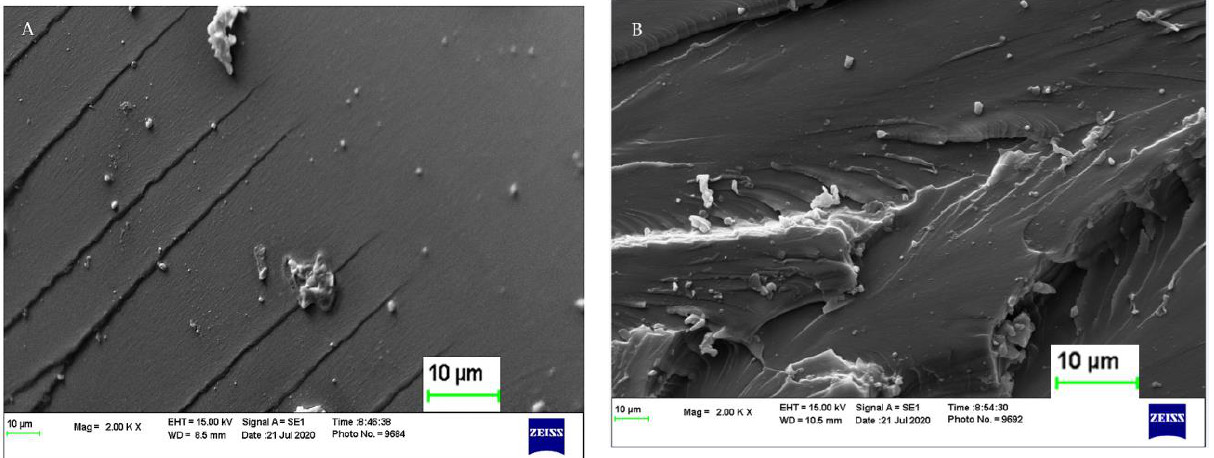
Figure 4. Morphology of cured epoxy samples by scanning electron microscopy. ( A ) Neat epoxy (left) and ( B ) epoxy-substituted bio-oil (right).